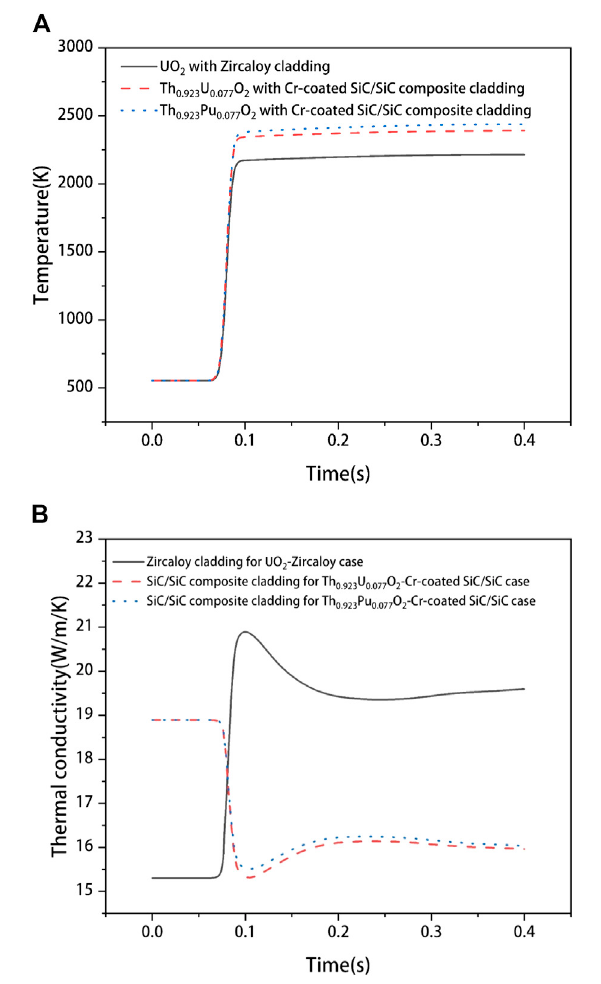
FIGURE 21 | (A) Fuel centerline temperature evolutions for the UO 2 fuel withZircaloycladding,theTh 0.923 Pu 0.077 O 2 fuel,andTh 0.923 U 0.077 O 2 fuelwith Cr-coated SiC/SiC composite cladding under the RIA condition. (B) Thermal conductivity evolutions of Zircaloy cladding for UO 2 – Zircaloy case, SiC/ SiC composite for Th 0.923 U 0.077 O 2 – Cr-coated SiC/SiC and Th 0.923 Pu 0.077 O 2 – Cr-coated SiC/SiC